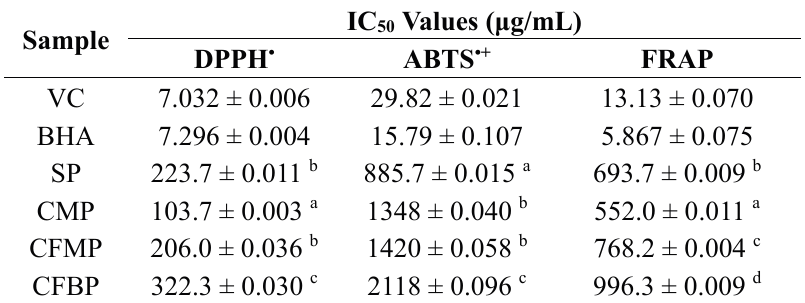
Table 4. The IC 50 values of BHA, VC and the four A. mellea polysaccharides for DPPH radicals, ABTS radicals and reducing